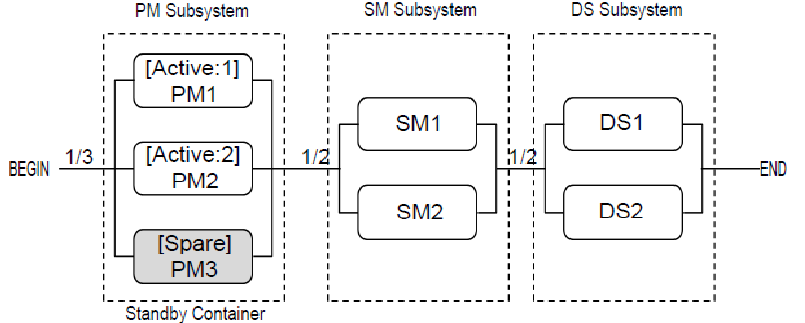
Fig. 2. RBD of the real-time computing